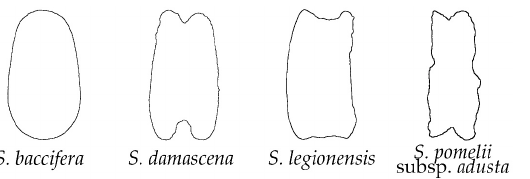
Figure 2. Silhouettes of the dorsal views of seeds in the group of smooth outline.